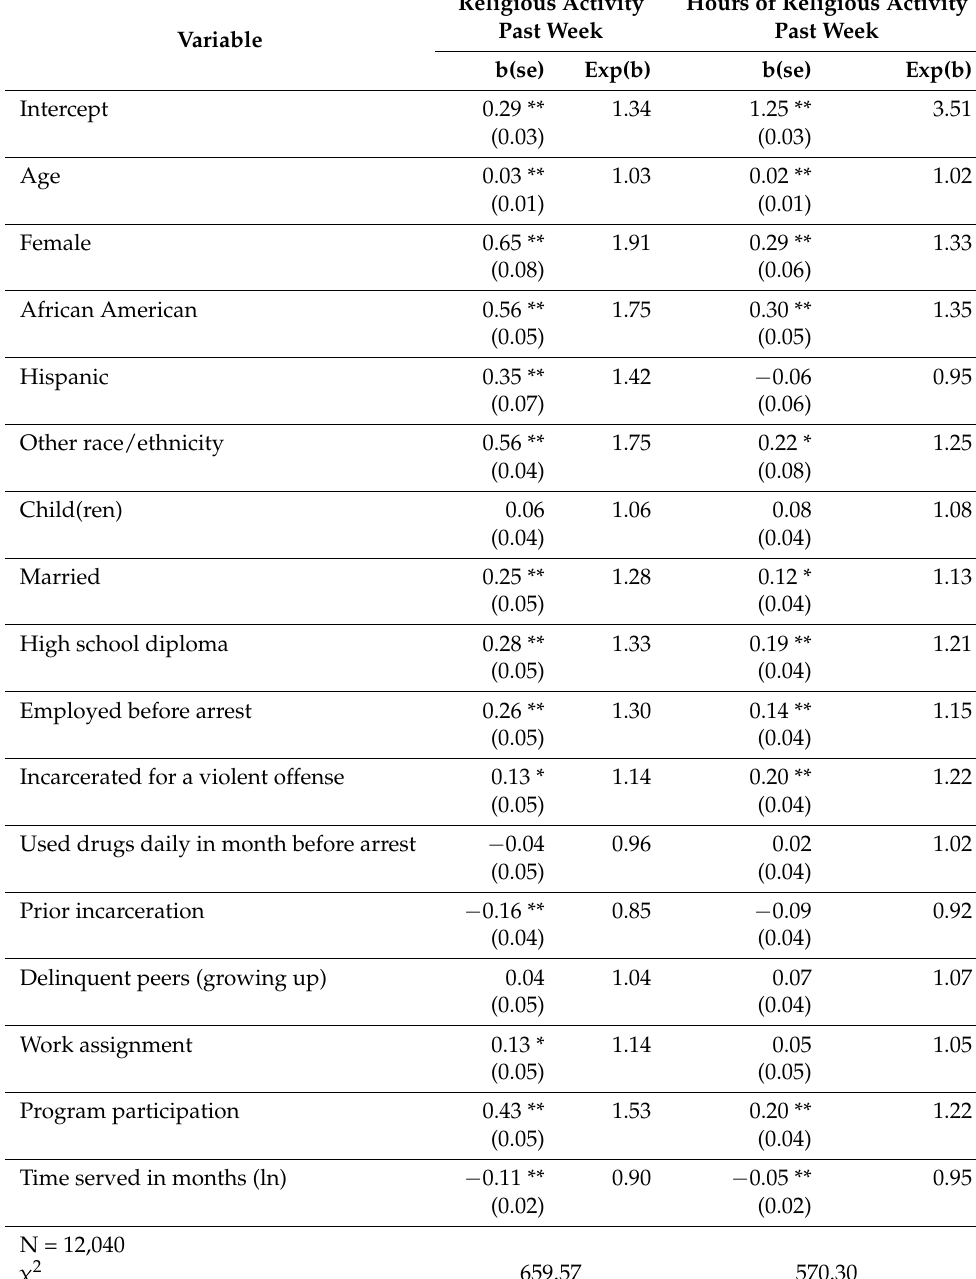
Table 2. Inmate-level predictors of